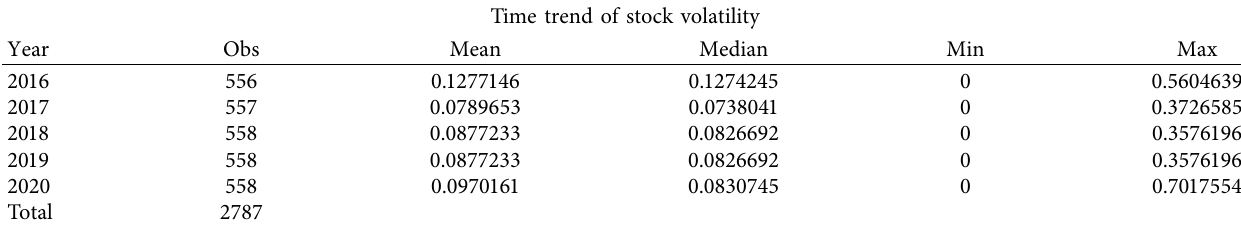
Table 1: Stock price volatility over the sample period from 2016 to